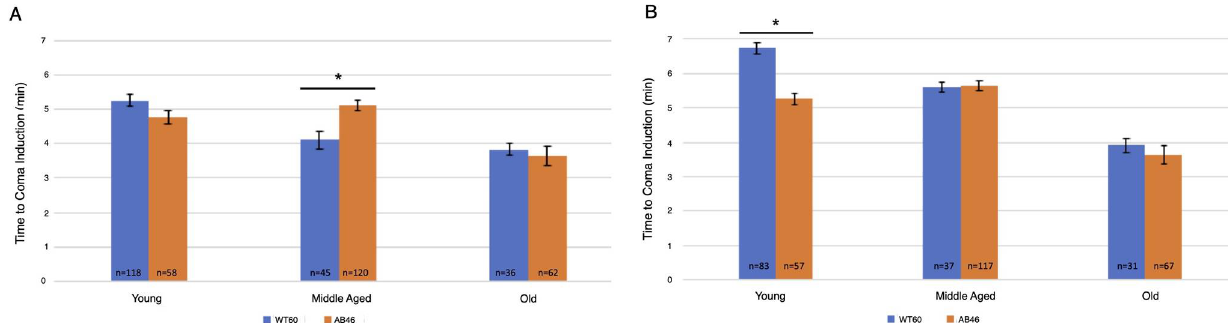
Figure 2. Moderate and slow induction of spreading depression. Wild-type (WT60) and MSR-deficient (AB46) animals were exposed to one hour of hypoxia. A nitrogen gas flowrate of 1.4 L/s was used for a moderate rate of induction ( A ) while a flow rate of 25 mL/s was used for a slow rate of induction ( B ). Onset of the coma was scored when the IR detector no longer recorded movement. The number of individual animals ( n ) used for each age-group and genotype is shown on the graph. Error bars are the SEM. Significance is indicated by an asterisk where p < 0.0001 using an unpaired t -test.